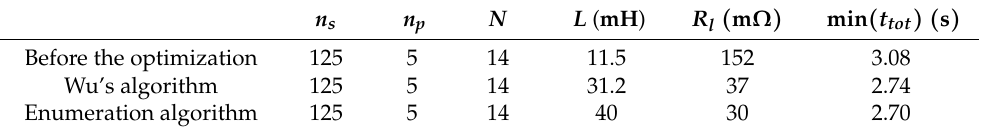
Table 8. Comparison results of the two algorithms.